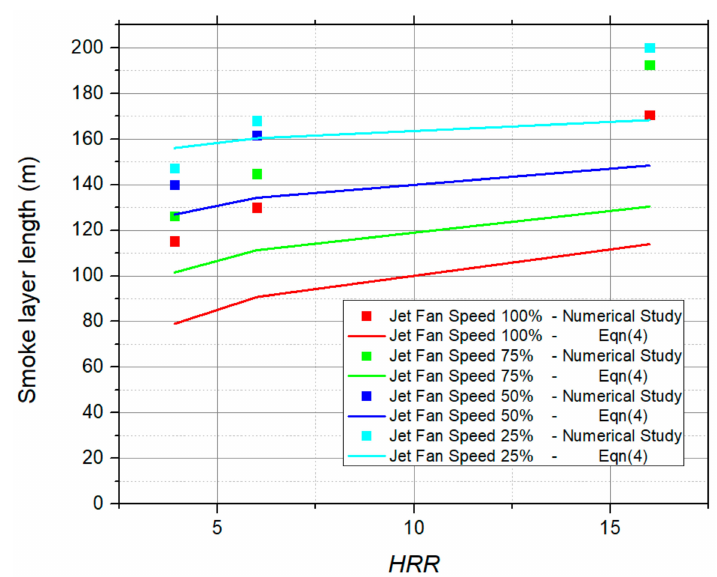
Figure 13. Smoke back layer length in the relationship between HRR and jet fan speed.